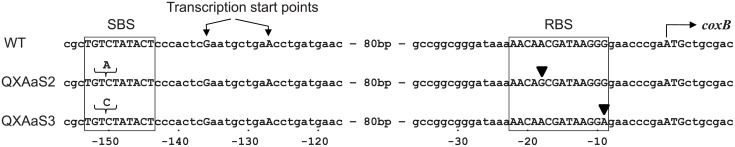
Suppressor mutations in the 5′-flanking region of coxB in QXAaS2 and QXAaS3.The putative RpoS binding site (SBS), transcription start points, ribosome binding site (RBS), and the initiation codon of coxB are shown in capital letters. Insertion mutations are indicated by braces. Point mutations are indicated by inverted triangles. The numbers below indicate the position relative to the initiation codon of coxB.